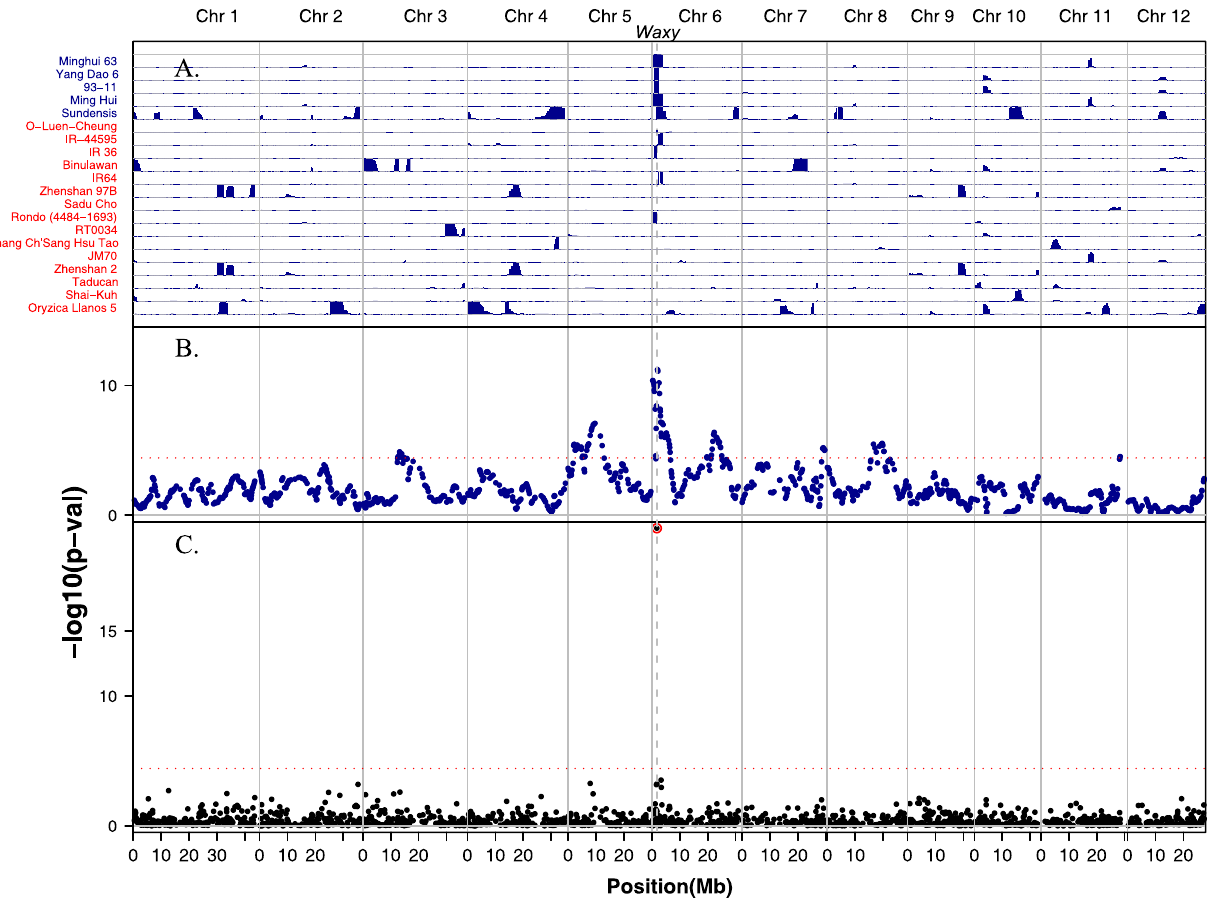
Figure 4. Regions of introgression from temperatejaponica into indica aligned with admixture mapping and association mapping p-values for amylose content. Genome position of SNPs and introgressions indicated across the bottom; vertical grey lines indicate chromosomes; position of Waxy gene on chromosome 6 shown as vertical dashed line. (A) Horizontal grey lines indicate accessions; blue-colored regions represent introgressions (defined by $ 5 SNPs)from temperatejaponica into indica ; varietynames (on left) colored dark blue indicate indica accessionscarrying a waxy allele introgressed from temperate japonica ; those without waxy introgression indicated in red. (B) Admixture mapping p-values for amylose content using the temperate japonica component in the admixed subpopulation. (C) Association mapping p-values for amylose content in all accessions using mixed model approach. Horizontal dotted lines in both (B) and (C) represent significance values of 0.05 after Bonferroni correction. doi:10.1371/journal.pone.0010780.g004 PLoS ONE |